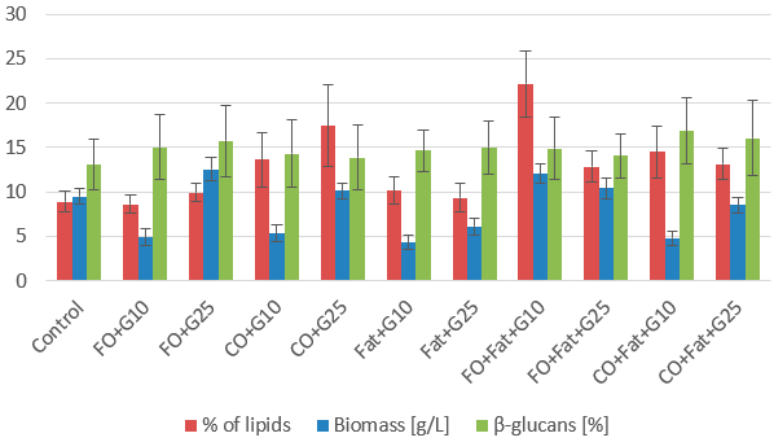
Figure 2. Phase I: Biomass, lipid, and β -glucan production of Rhodotorula kratochvilovae cultivated on a combination of waste lipids and glycerol.